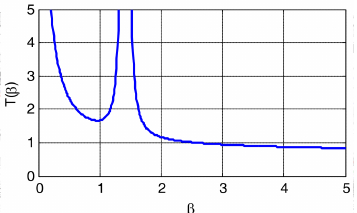
Figure 3. Normalized expectation error. β : scale factor; T( β ): error.